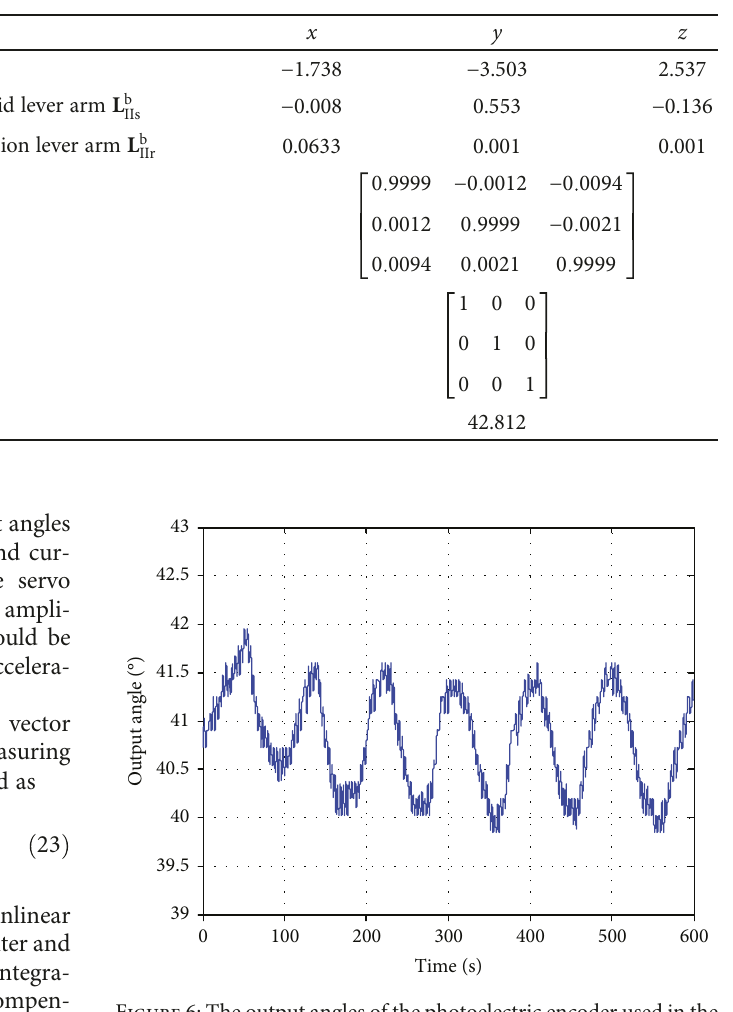
Table 2: Calibration result of the experiment system in Figure 5.